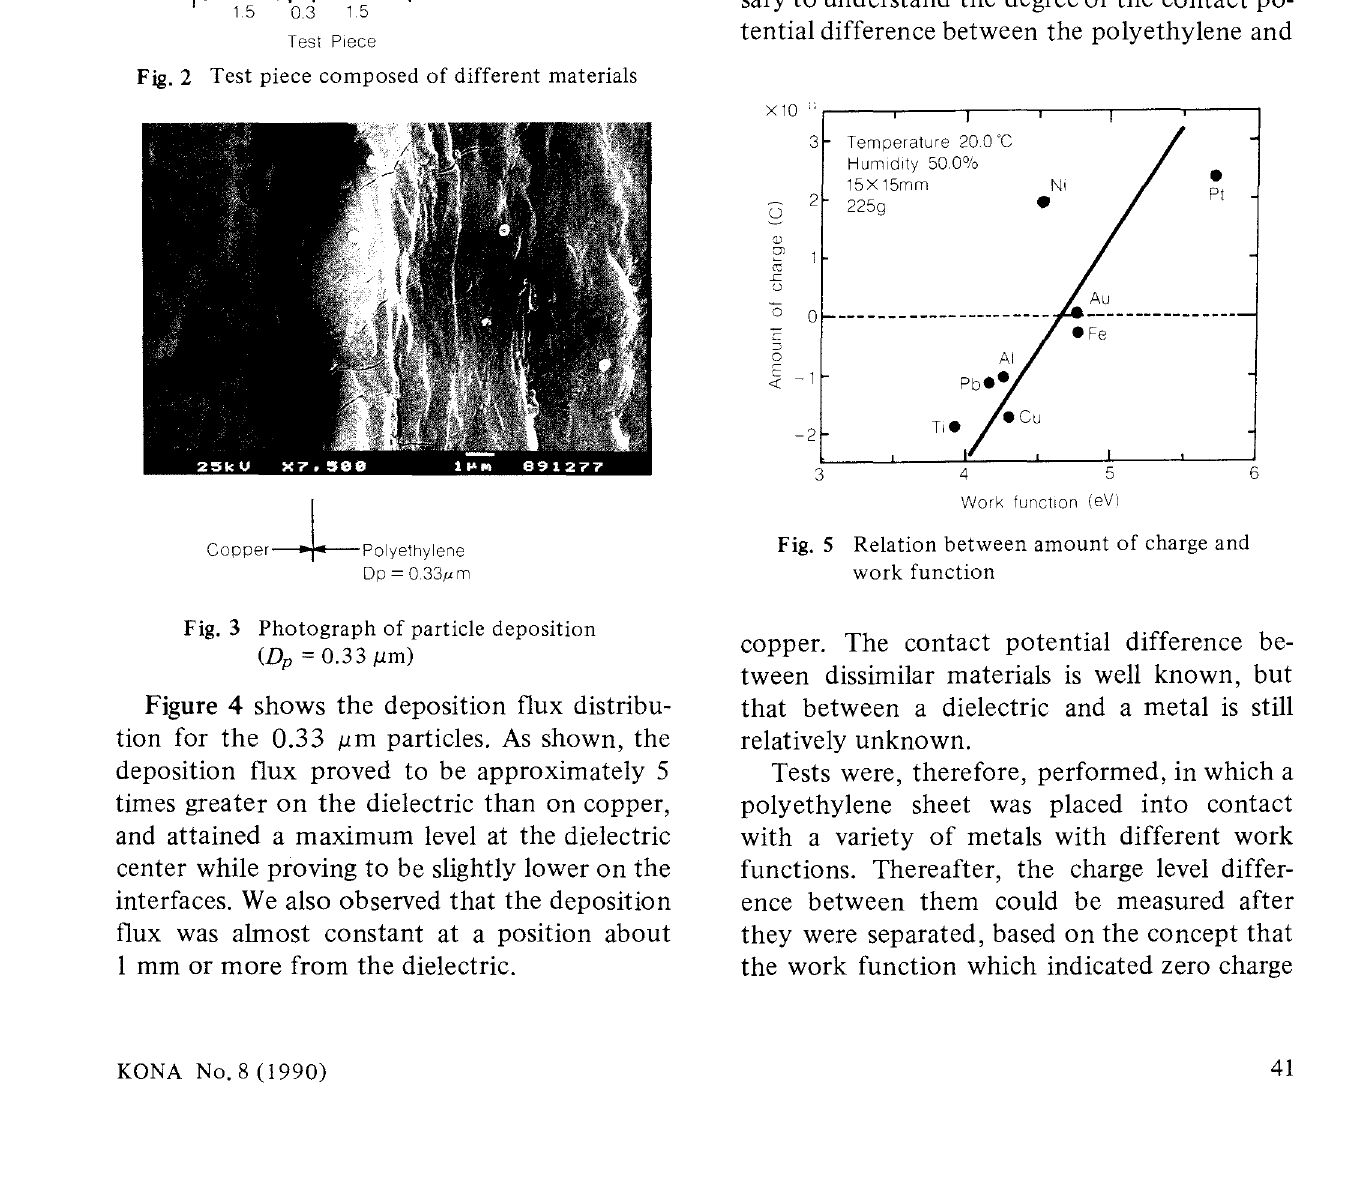
Fig. 5 Relation between amount of charge and work function